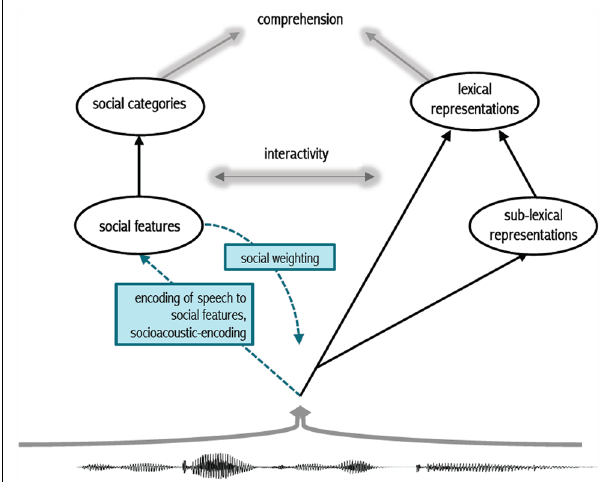
FIGURE 2 | Schematic of proposed dual-route approach. In tandem with the encoding of speech to sounds and words (right), acoustic patterns in speech are encoded to social representations (left). Socially weighted encoding results from the heightened activation of social representations that modulates attention to the speech signal.This in turn results in the deep encoding of socially salient acoustic patterns along with linguistic representations, but also independent of